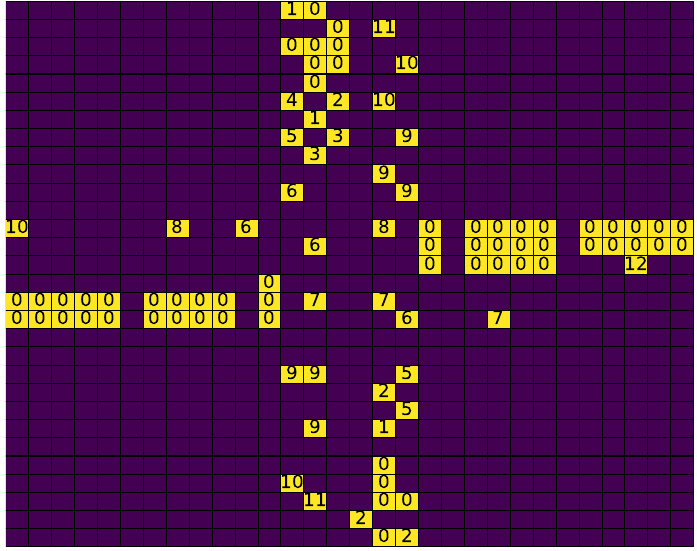
Figure 3. An example of traffic state